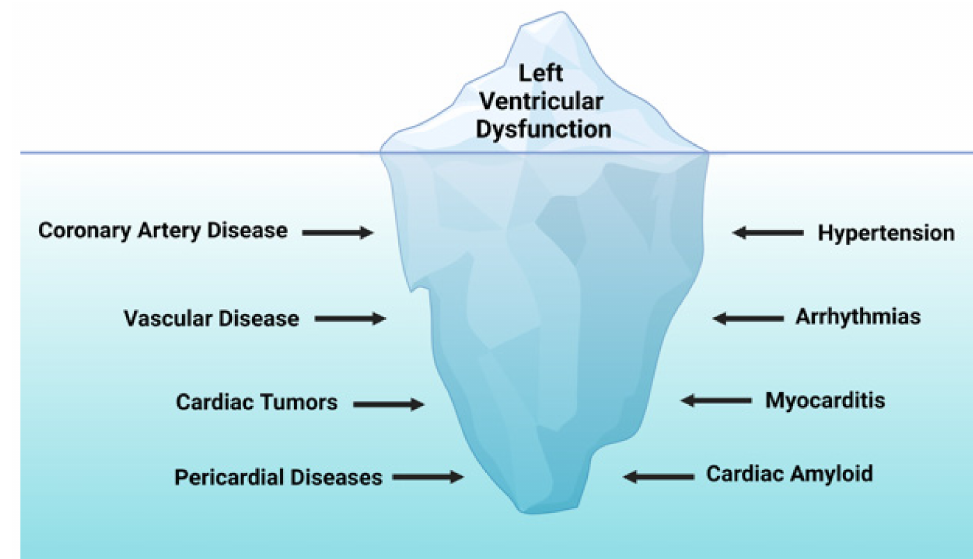
Figure 3. Underlying causes of heart failure in PedCO. Created with BioRender.com.